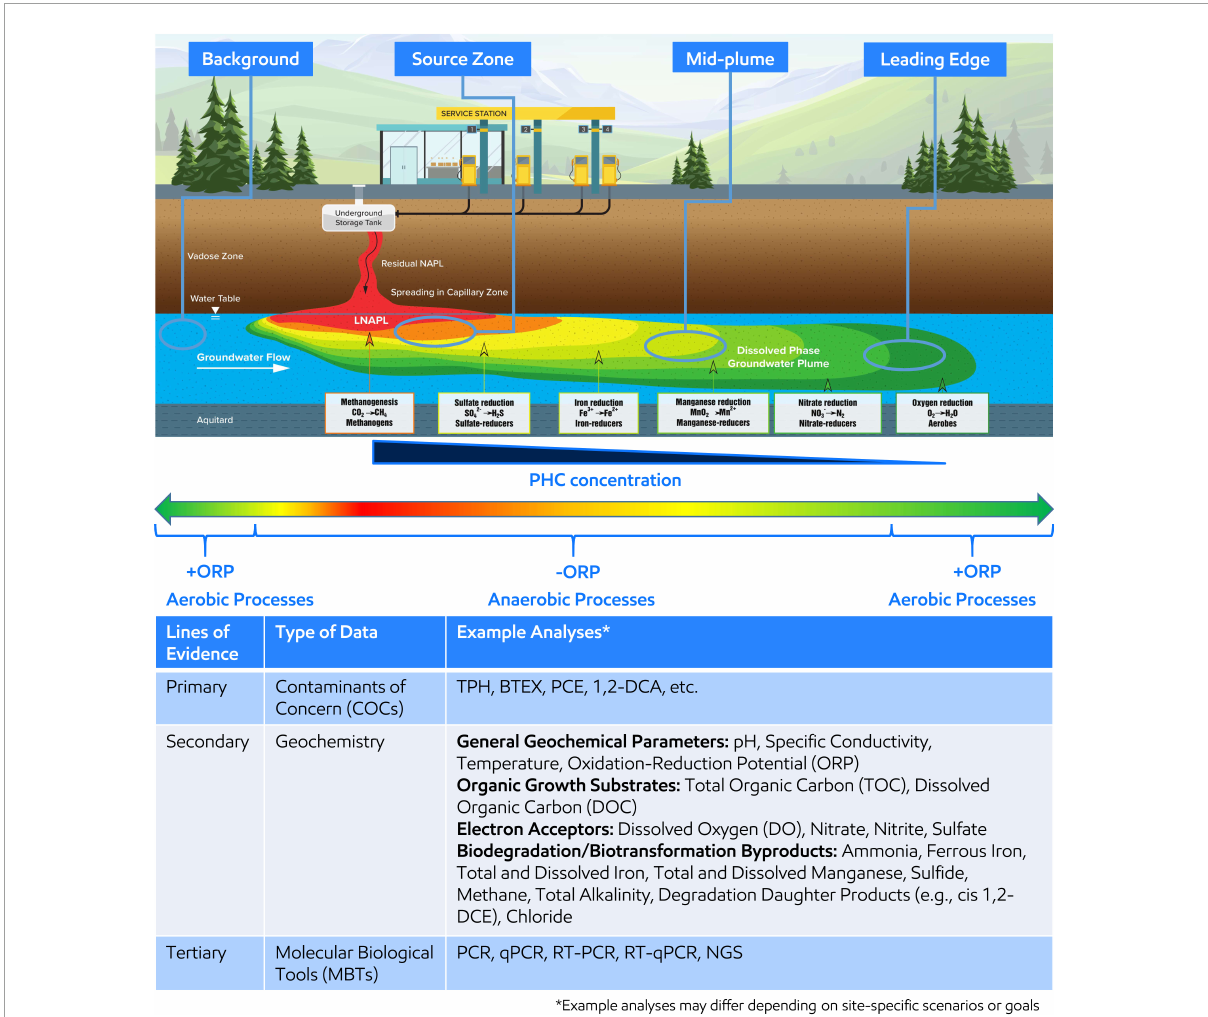
FIGURE1 (Top) Idealized groundwater plume resulting from petroleum hydrocarbon (PHC) release and the dominant redox conditions, electron acceptor utilized during microbial respiration, and associated microorganisms along the plume length. Oxidative reduction potential (ORP) is shown across the plume length where red, orange, yellow, and yellow-green indicate reducing conditions associated with the highest PHC concentration around the light non-aqueous phase liquid (LNAPL) body or source zone and green indicates oxidizing conditions associated with the lowest PHC concentration at the leading edge of the plume or upgradient of the plume. Four areas of the plume, background, source zone, mid-plume, and leading edge, are circled to indicate recommended areas for MBT sampling. (Bottom) The table demonstrates and summarizes example analyses to be considered when developing an MBT sampling plan within a MLOE